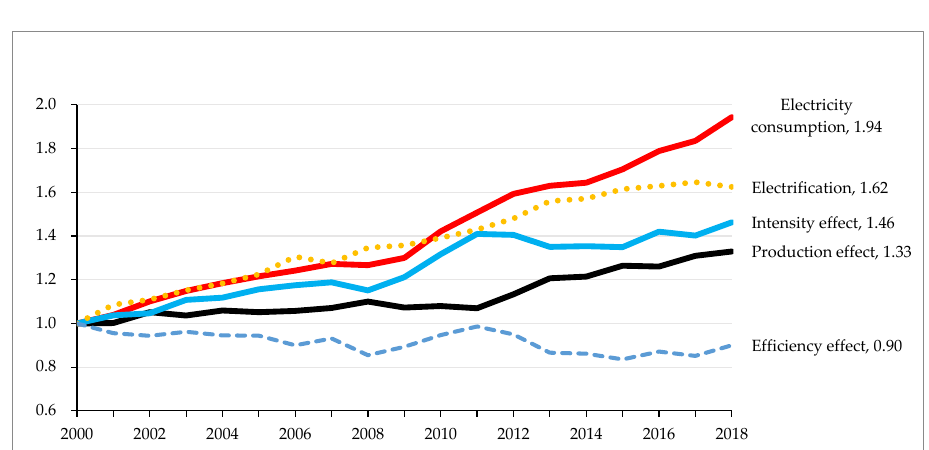
Figure A1. Food and tobacco electricity consumption LMDI results (fixed base year, multiplicative).